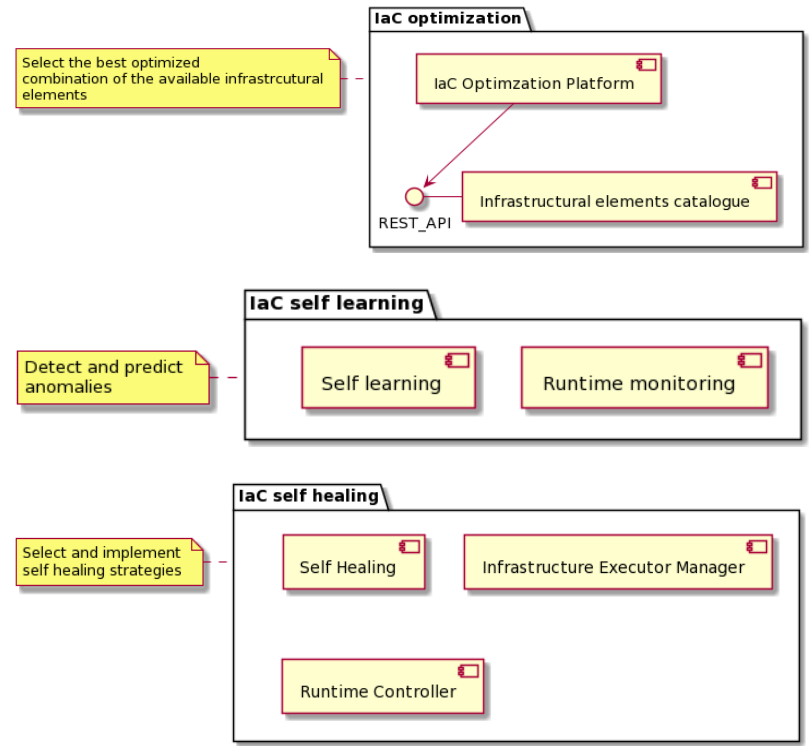
Figure 2. PIACERE approach for optimized and self-healed IaC.